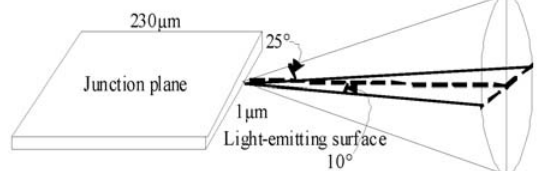
Figure 6. Illustration of ligh-emitting surface and divergencey